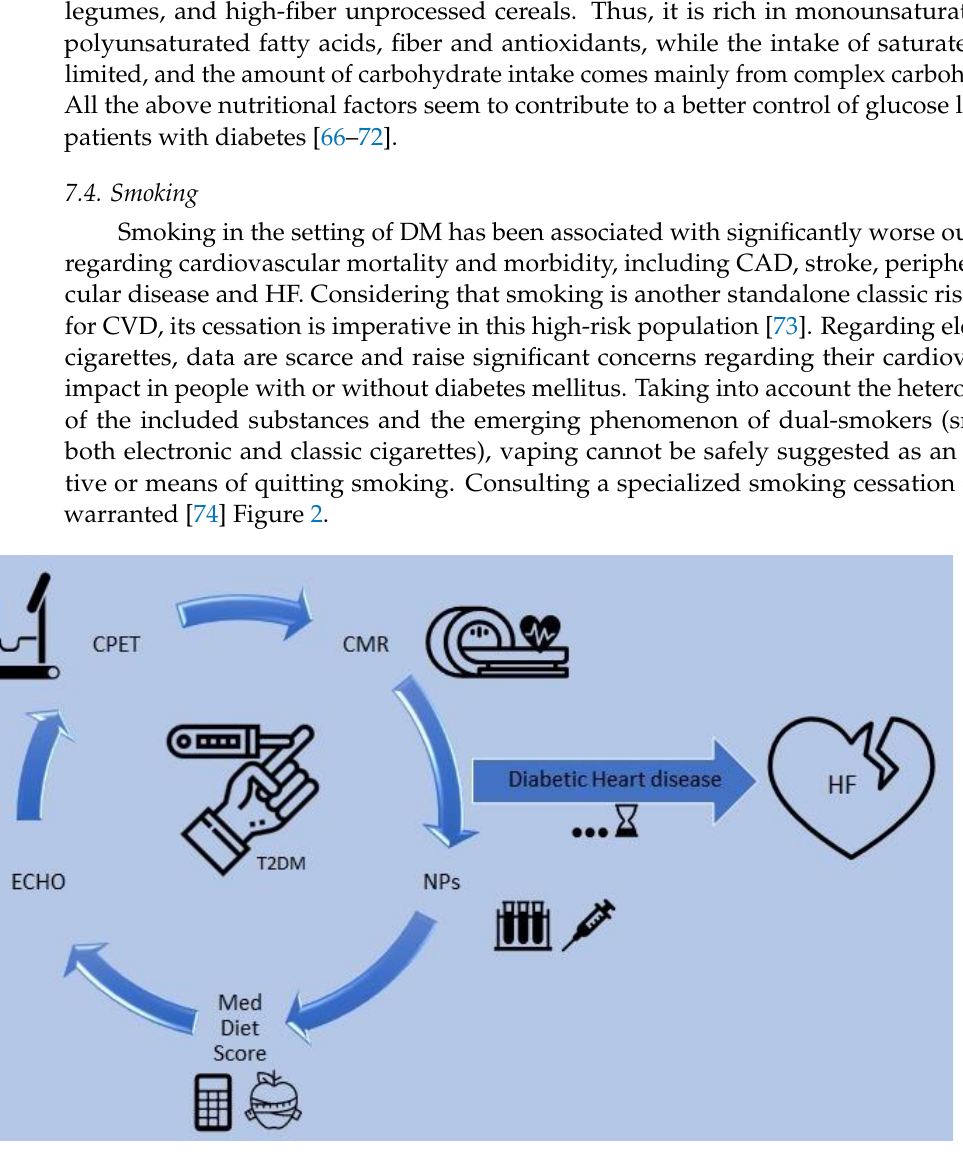
Figure 2. Prognostication of heart failure in patients with T2DM. CMR: cardiac magnetic resonance, CPET: cardiopulmonary exercise test, ECHO: echocardiogram, HF: heart failure, Med: Mediterranean, NPs: natriuretic peptides, T2DM: type 2 diabetes mellitus. The diagram presents a proposed evaluation of T2DM patients for risk stratification of heart failure, involving cardiac imaging, functional capacity, the Mediterranean diet score and biomarkers.